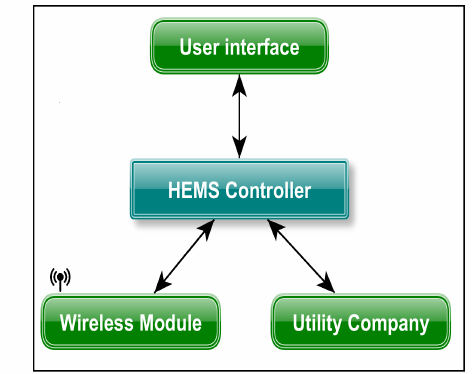
Figure 3. Simple structure of a home energy management system (HEMS) controller.